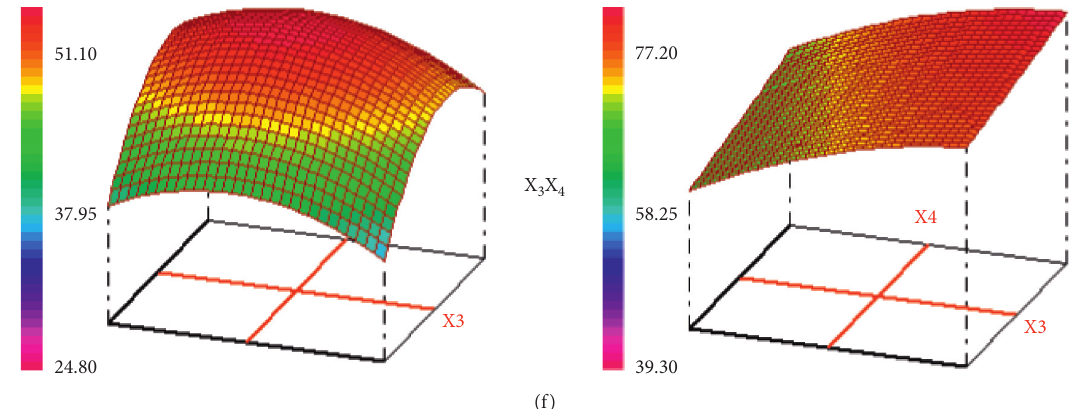
Figure 4: Response surface plot of TFC (mg QE g-1 DW) of Eucalyptus marginata leaves extracts as a function of time, temperature, ratio s/ m, and ethanol concentration obtained by maceration and ultrasound-assisted extraction methods. The extraction time (min, X 1 ), temperature ( ° C, X 2 ), liquid/solid ratio (ml/g, X 3 ), and ethanol concentration (%, X 4 ).